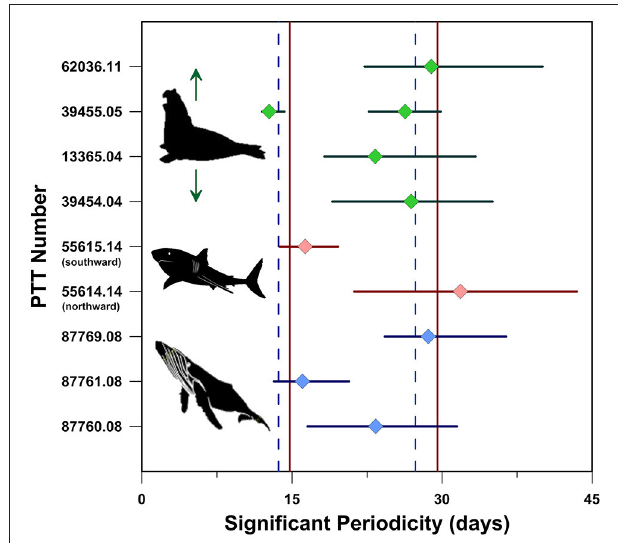
FIGURE 4 | Significant ( p < 0.05) periodicities in long-distance route fidelity tracks revealed by spectral analysis. Colored diamonds correspond with the highest power (i.e., peak) periodicity and horizontal bars correspond with the range in significant ( p < 0.05) periodicities detected using the Lomb-Scargle algorithm (Scargle, 1982). Red vertical lines correspond with the 29.53 and 14.76 day-long moon illumination (i.e., synodic) cycle and semi-cycle, respectively. Dashed blue vertical lines correspond with the 27.32 and 13.66 day-long moon declination (i.e., sidereal) cycle and semi-cycle, respectively, and are shown for